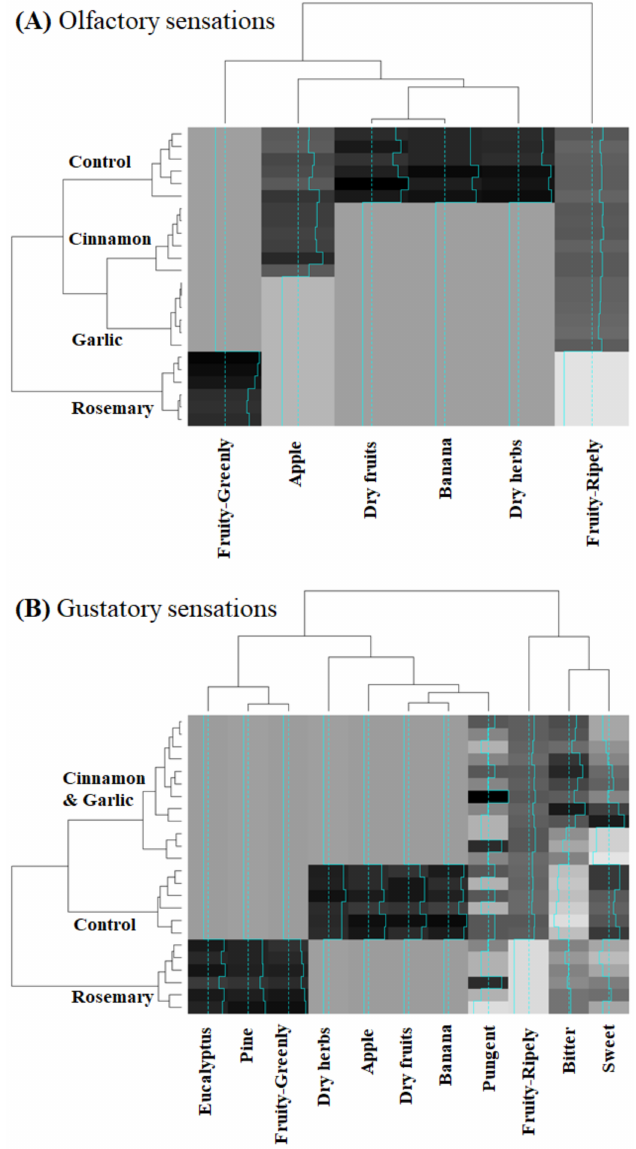
Figure 1. Hierarchical clustering heatmap (using Euclidean distances and Ward method) and respective dendograms for variables and unflavored cv. Arbequina oils (control oils) or oils flavored with cinnamon, garlic, or rosemary (white-black color scale: variable with lowest to highest influence,